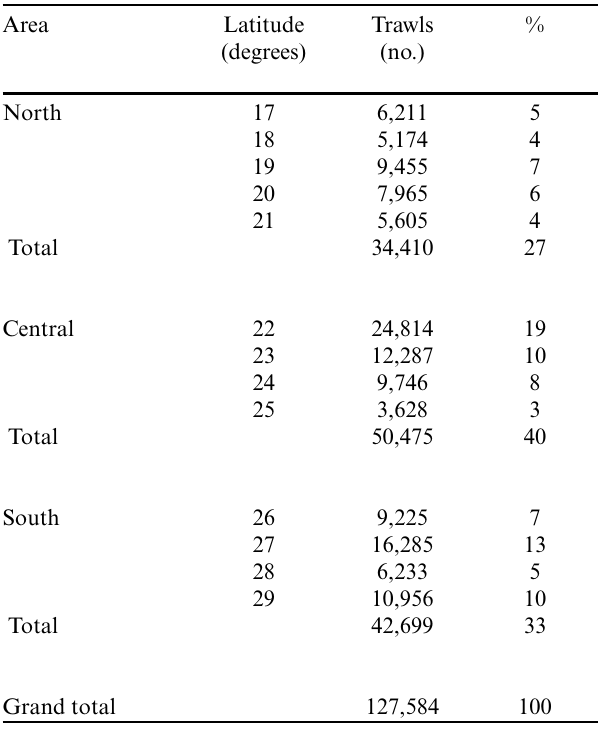
Table 1 . Number of trawls per fishing area and by degrees of latitude, 2003 to 2005. n=127584. Source: Namibia Ministry of Fisheries and Marine Resources' logbook